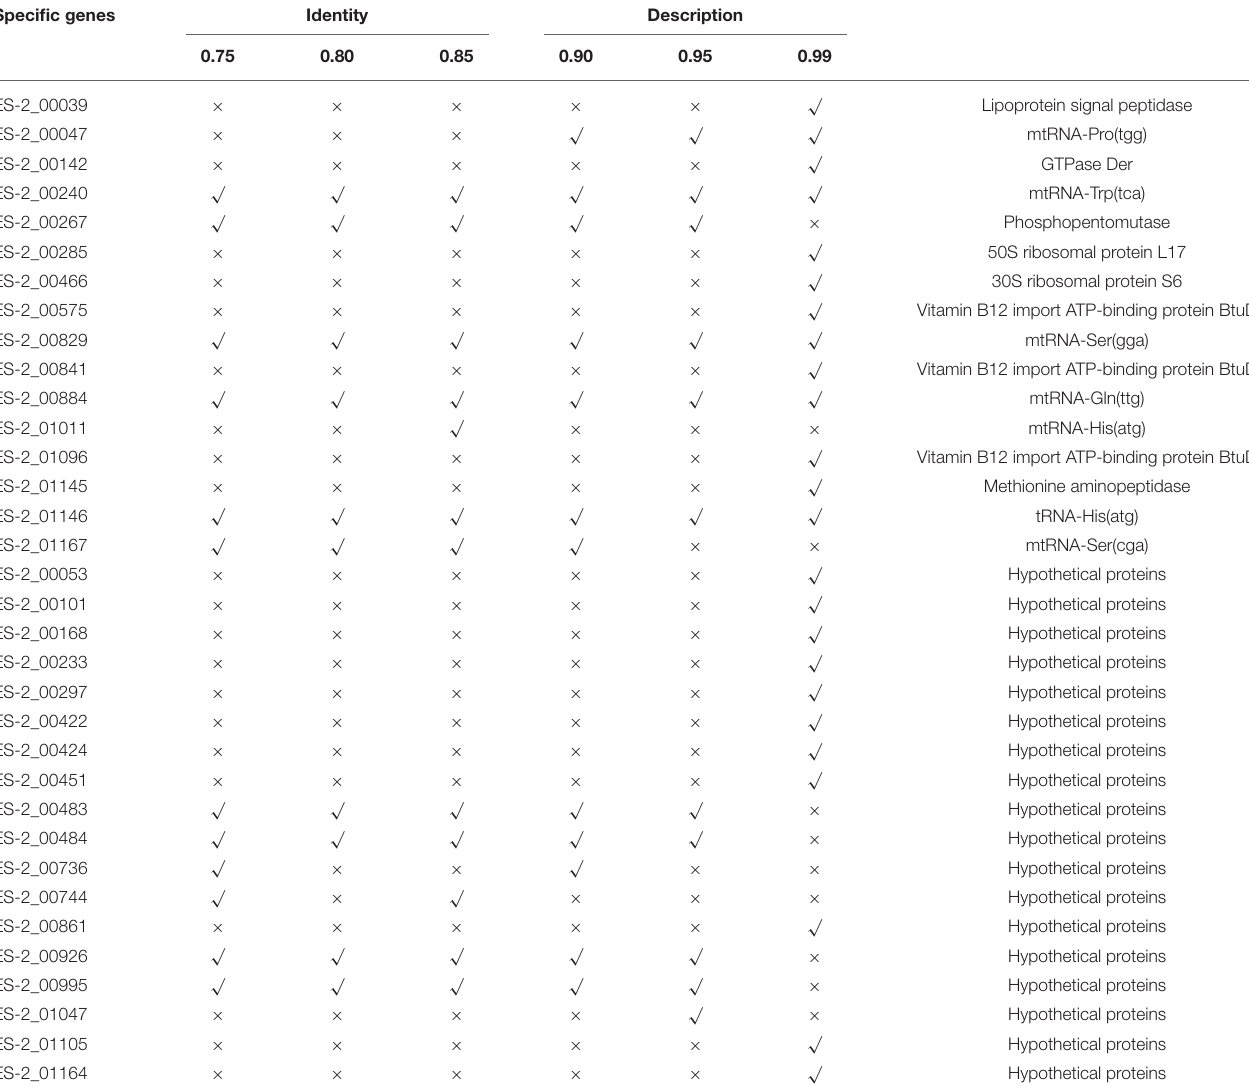
TABLE 1 | The genes present in pathogenic M. hyopneumoniae strains but absent in nonpathogenic M. hyopneumoniae strains at the amino acid level. Specific